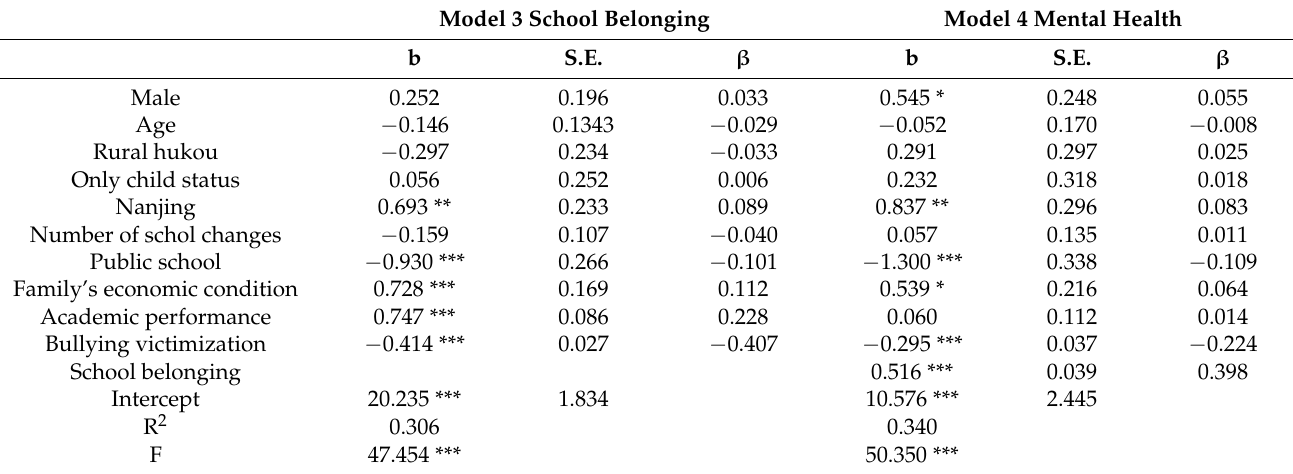
Table 4. Results of mediation model.